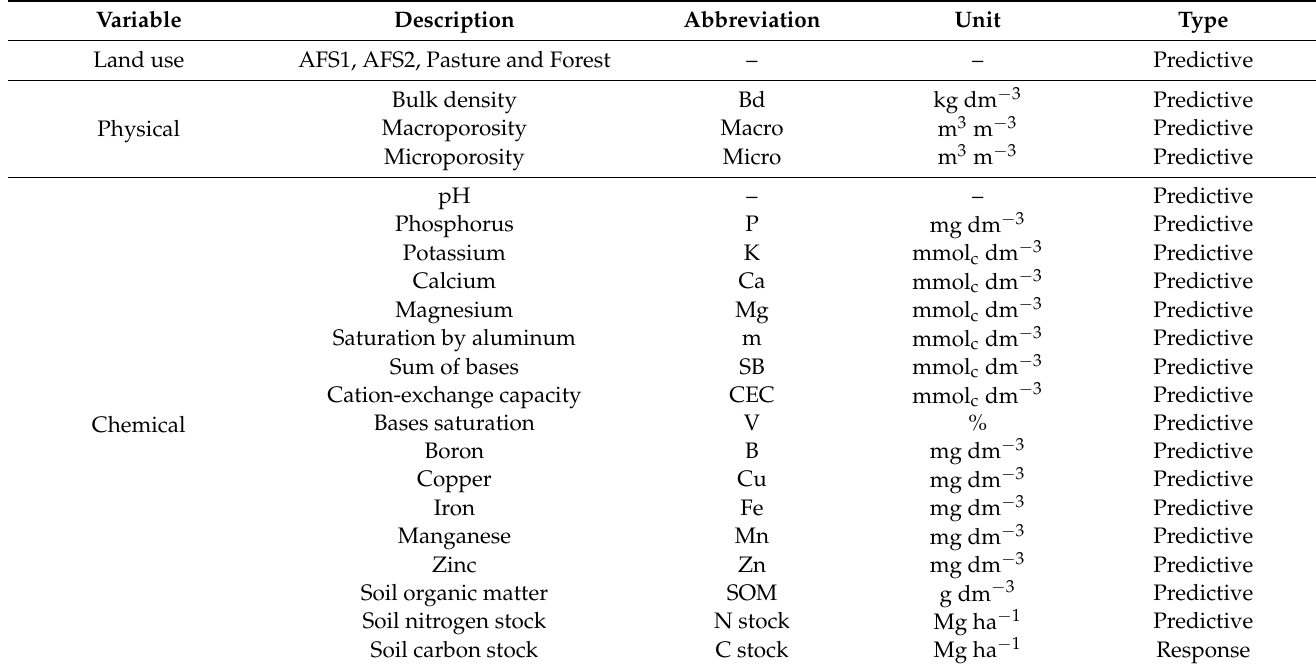
Table 2. Physical and chemical variables in soil used to compose the database to predict soil carbon